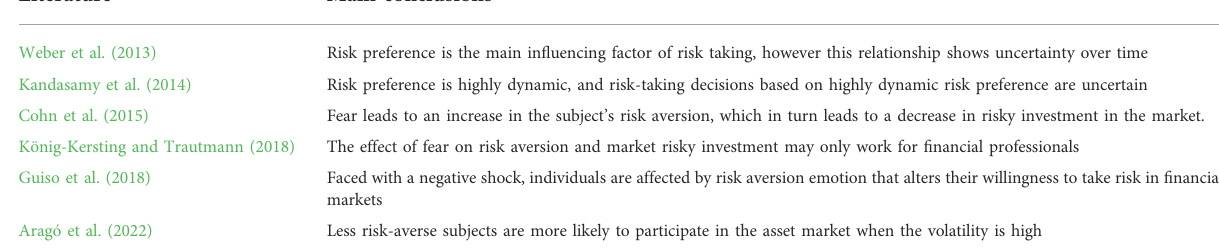
TABLE 1 Summary of research conclusions on the relationship between risk preference and willingness to take